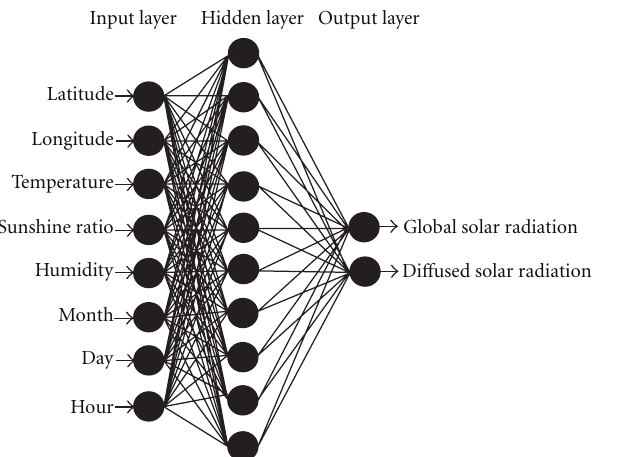
Figure 2: FFNN for solar radiation prediction.